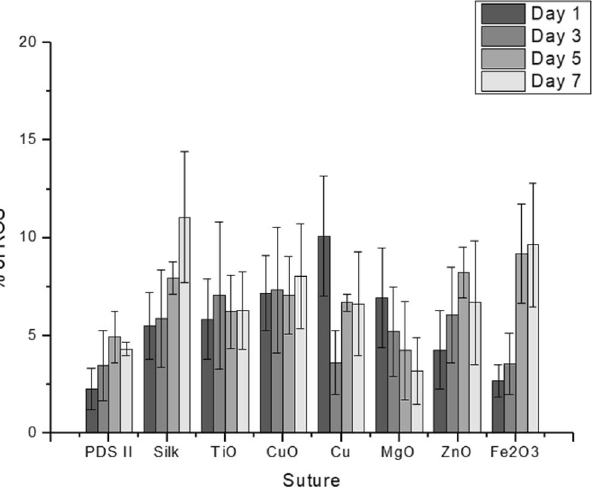
Figure 4. ROS production represented by % of ROS in the aqueous suture testing environment at each timepoint (1, 3, 5, 7 days) (n = 3). ANOVA and Tukey tests were performed with the weight differences in coated against weight differences in the uncoated